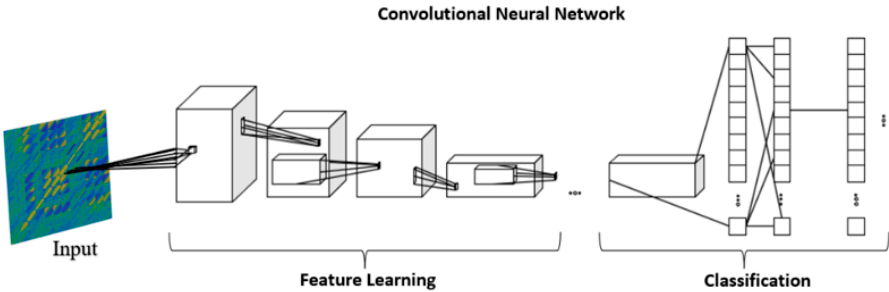
Figure 12. Flowchart of the CNN employed for the classification of the gait pattern into physiological and PD classes.